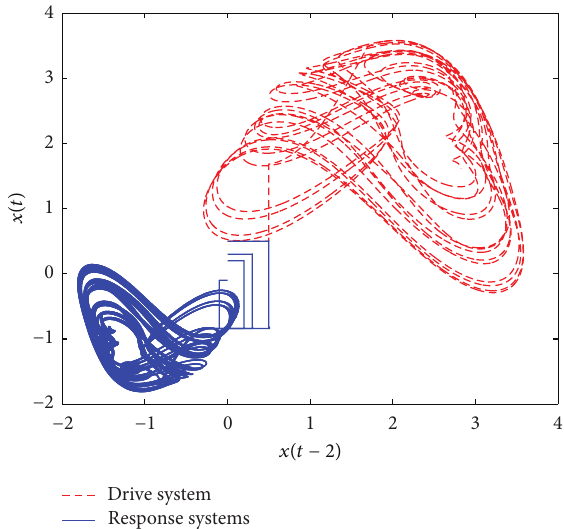
Figure 2: Chaotic attractors of systems (27) and (28) with 𝜆 = −0.5 .